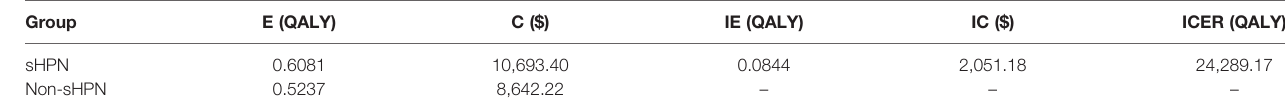
TABLE 2 | Primary outcomes of cost-effectiveness analysis. Group